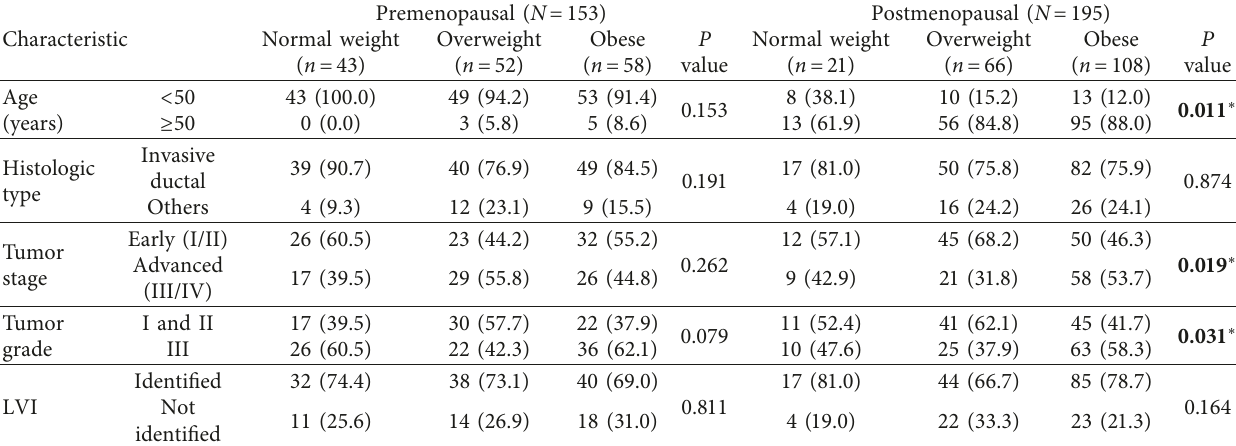
Table 4: Association of clinicopathologic characteristics with BMI among premenopausal and postmenopausal breast cancer patients ( N �